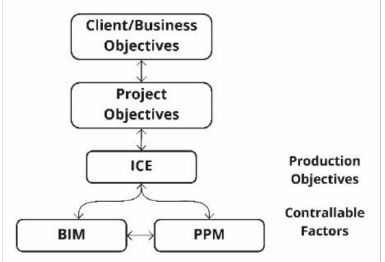
Figure 1. VDC framework, adapted from Rischmoller et al.